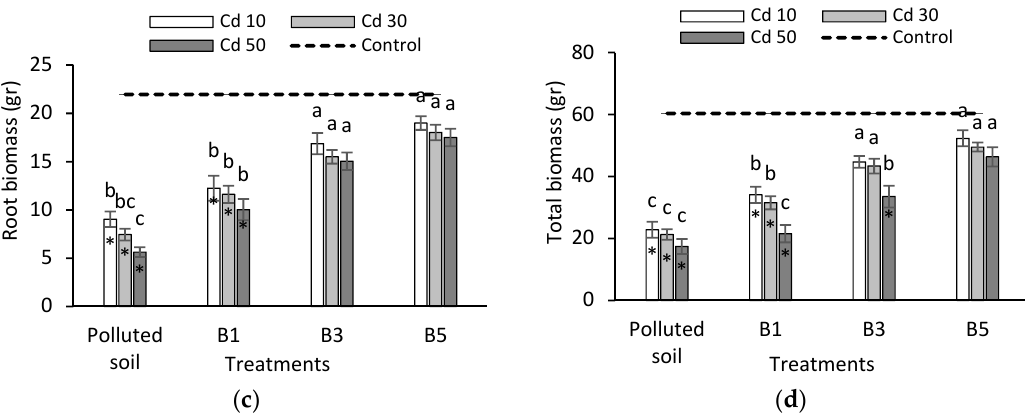
Figure 3. Effect of different levels of biochar on: ( a ) leaf biomass; ( b ) stem biomass; ( c ) root biomass; and ( d ) total biomass in oak seedlings at different levels of Cd contamination (bars represent means +/ − one standard deviation). The dashed line represents the control (no biochar, no Cd), and the term “Polluted soil” indicates pots with the Cd but without biochar. Different letters represent significant differences between treatments. The star indicates a significant difference between treatments and control.